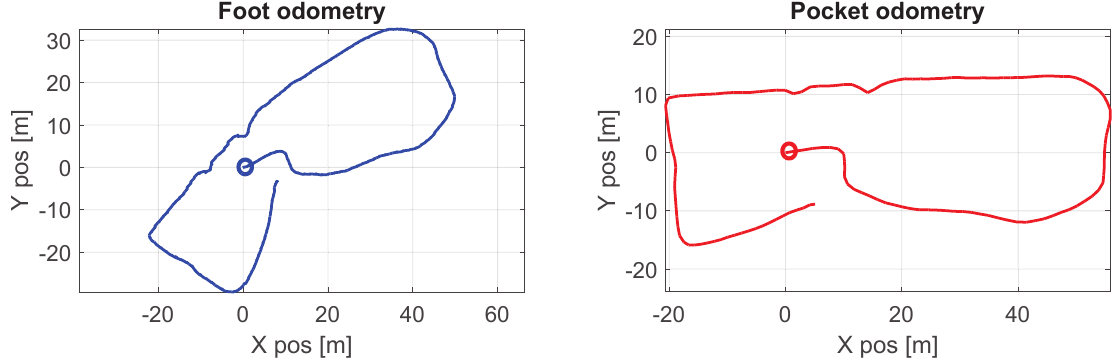
Figure 4. Odometry of a walk estimated by the foot INS ( left ) and the pocket INS ( right ) in Figure 2. The circles indicate the beginning of the walk. An observer cannot identify which INS has a better heading estimation without knowledge of the ground